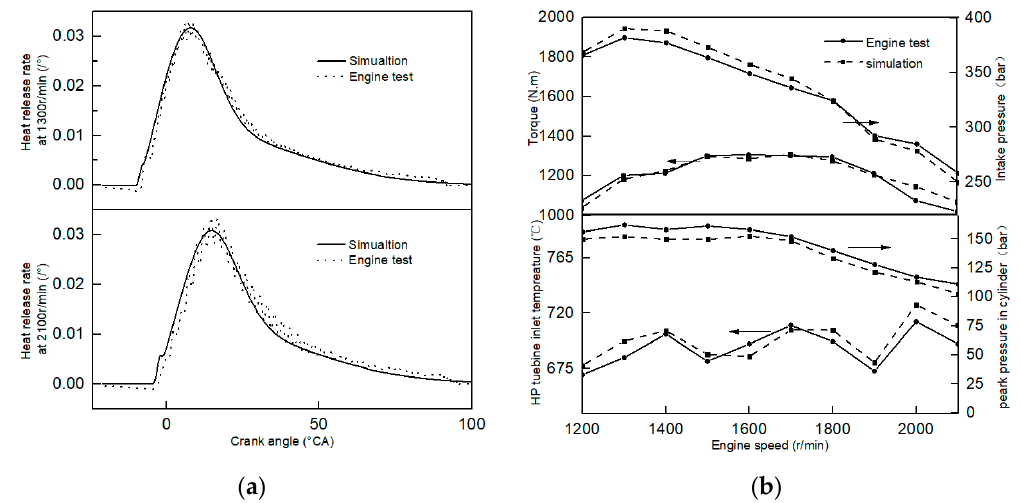
Figure 2. Calibration of simulation model. ( a ) Rate of heat release; ( b ) performance parameters.